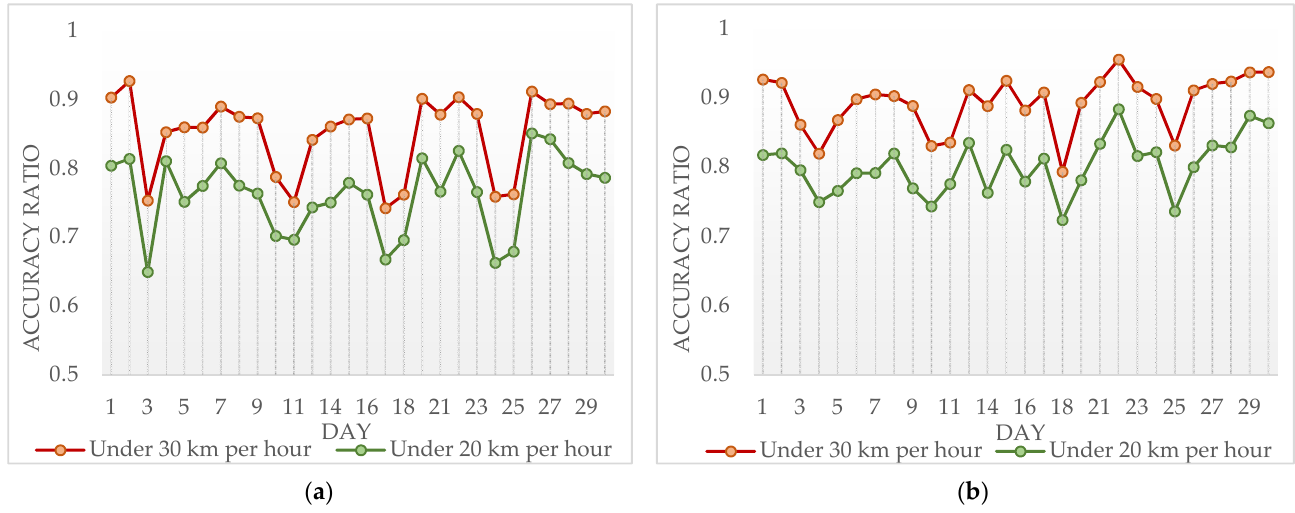
Figure 10. The accuracy ratios of the discovery of LMCPs under different congestion levels within 30 days. ( a ) The accuracy ratio of LMCPs during morning peak traffic hours; ( b ) The accuracy ratio of LMCPs during evening peak traffic hours.